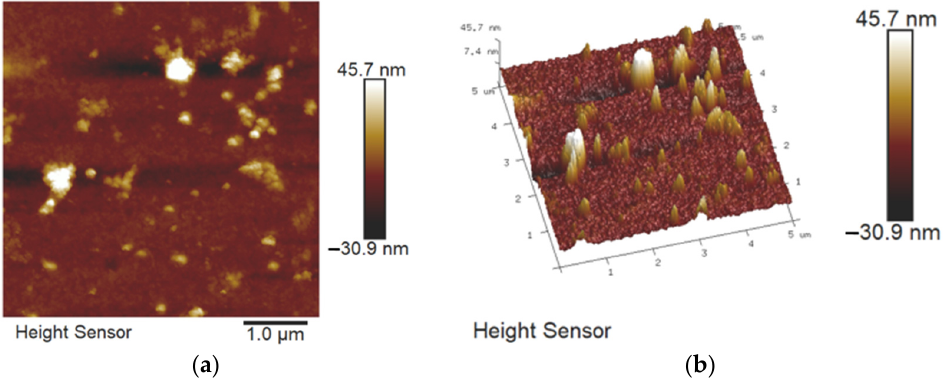
Figure 3. AFM images of ( a ) 2D and ( b ) 3D of as-fabricated APN film.